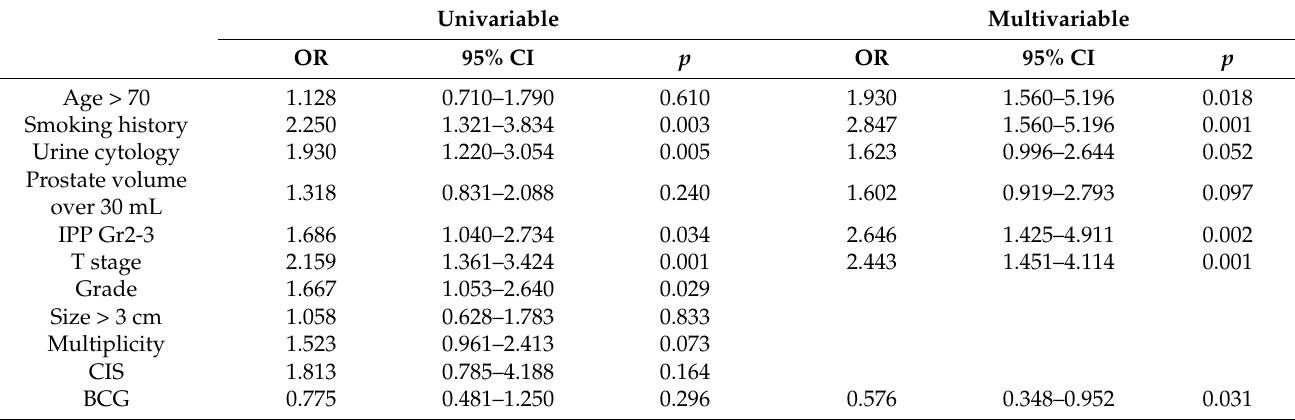
Figure 1. ( a ) Pearson correlation heatmaps between intravesical prostatic protrusion, known 10 risk factors, and recur- rence/progression of non-muscle invasive bladder cancer (NMIBC). ( b ) Comparison of coefficient magnitude of each risk factor for recurrence of NMIBC after TURBT in logistic regression analysis. ( c ) Changes in age according to IPP grade (mean ages are shown; error bars represent standard error of the mean). ( d ) Changes in prostate volume according to IPP grade (mean ages are shown; error bars represent standard error of the mean). CIS = carcinoma in situ; BCG = Bacillus Calmette–Gu é rin; BPH = benign prostatic hyperplasia; IPP = intravesical prostate protrusion. Table 2. Stepwise multiple logistic regression analysis for predictive factors of intravesical recurrence in non-muscle invasive bladder cancer after